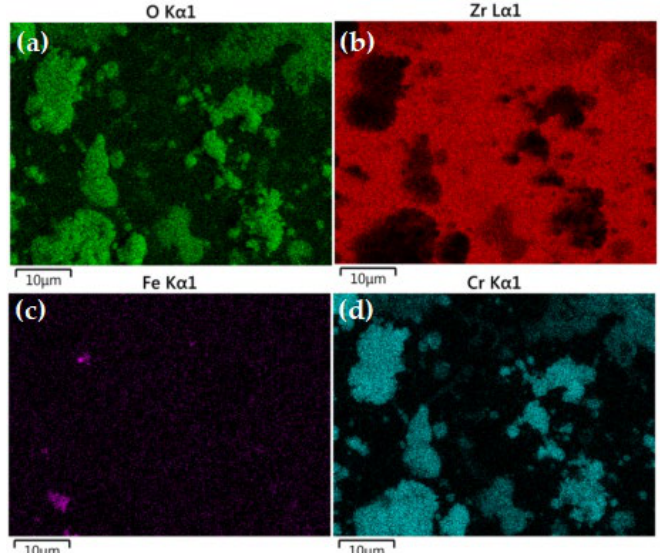
Figure 14. Surface scan of the Zr alloy after corrosion in a 400 ◦ C high-temperature and high-pressure water environment for 14 days: ( a ) Distribution diagram of O; ( b ) Distribution diagram of Zr; ( c ) Distribution diagram of Fe; ( d ) Distribution diagram of Cr.